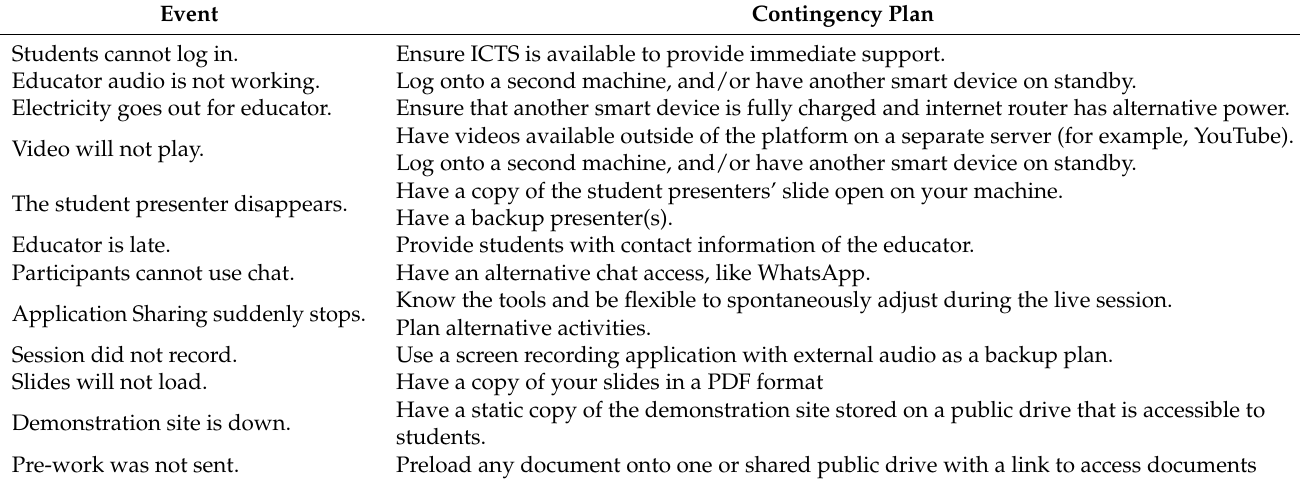
Table 3. Contingency plans for sample